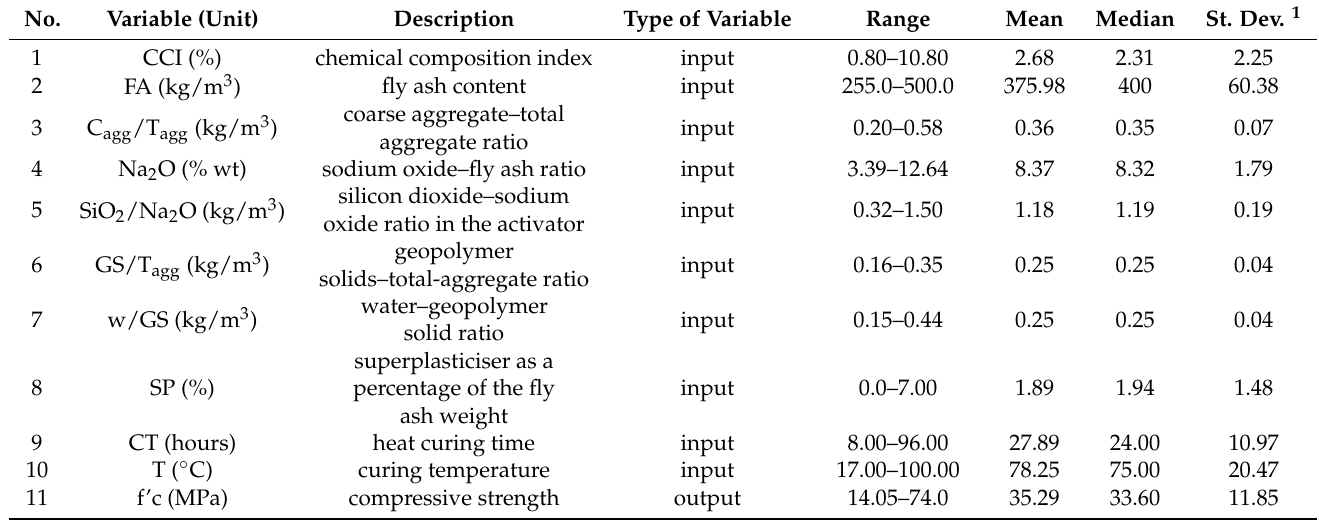
Table 1. Description and summary statistics of the input and output